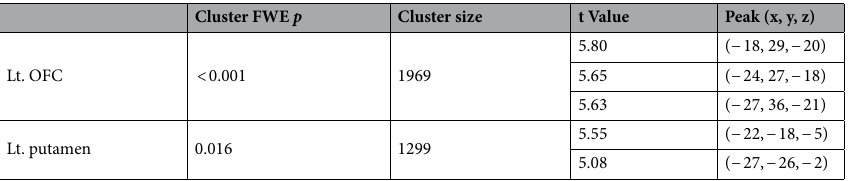
Table 2. Boxers specific anatomical structures ([Boxers (Time1) > Controls]). The statistical threshold for significant differences was set at FWE corrected p < 0.05, at the cluster level with uncorrected p < 0.001 at the voxel level. Lt, left; OFC, orbitofrontal cortex.